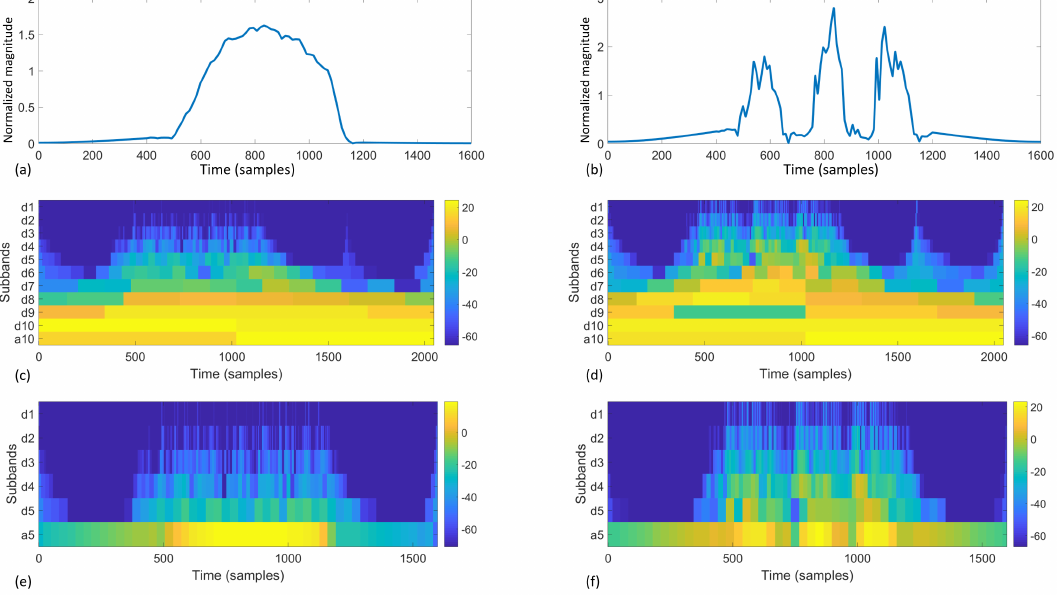
Figure 8. Visual illustration of wavelet transform. ( a , b ) are the source signal; ( c – f ) are scaleograms of the wavelet transform coefficients; ( c , e ) are the results from ( a ); ( d , f ) are the results from ( b ); ( c , d ) are the results of 10 filterbank iterations; ( e , f ) are 5 filterbank iterations.